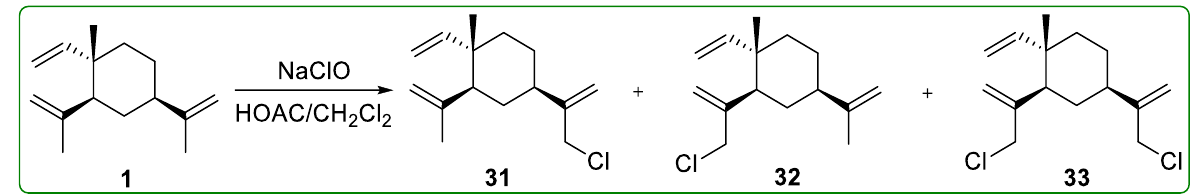
Figure 6. The chlorination reaction and the chemical structures of related products 31 – 33 .